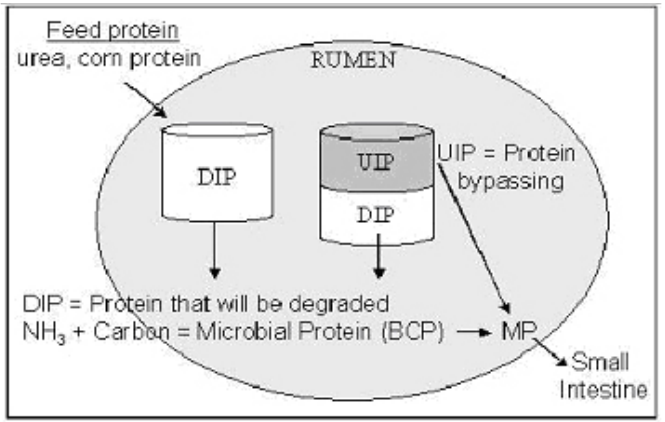
FIGURE 1 . Diagrammatic representation of the metabolizable protein (MP) system adopted in the 1996 NRC illustrating flow of degradable intake protein (DIP) and undegradable intake protein (UIP) through the rumen. All feed proteins will be degraded by varying degrees by rumen microbes. An example is urea which is completely degradable while most other feedstuffs contain both UIP and DIP fractions. MP is the sum of microbial protein and UIP that enters the small